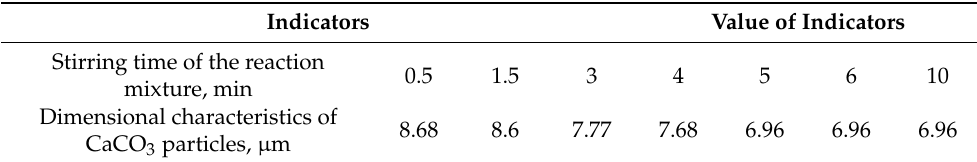
Table 1. Influence of the mixing time of the reaction mixture on the dimensional characteristics of calcium carbonate templates. Indicators Value of Indicators Stirring time of the reaction 0.5 1.5 10 mixture, min Dimensional characteristics of CaCO 3 particles, µ